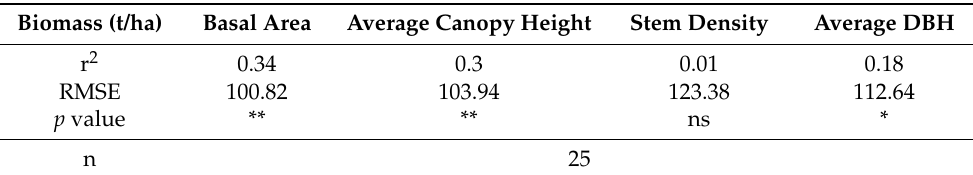
Table 3. Statistical relationships between field calculated aboveground biomass to basal area, average canopy height, stem number density and average tree diameter.